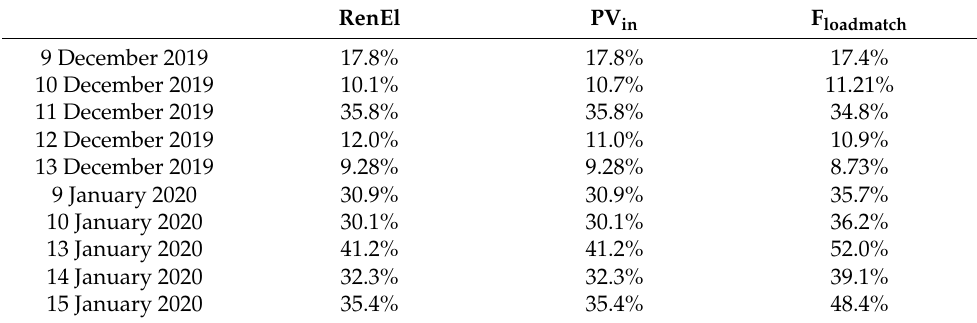
Figure 5. Daily energy balance between energy consumption and PV generation: ( A ) setpoint lower that 20 °C and ( B ) upper 20 °C. Table 4. Hourly indices regarding energy balance.